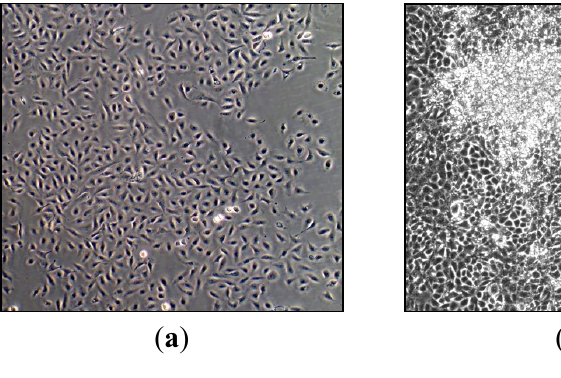
cells. ( b ) Focus produced after exposure to 1 μg/cm 2 nickel subsulfide. ( c ) Focus produced after exposure to 2.5 μg/cm 2 nickel